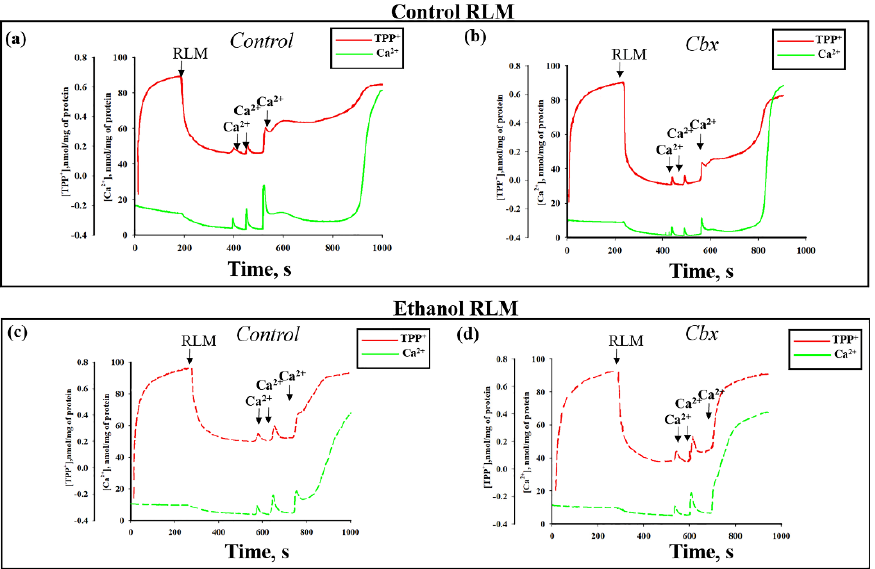
Figure 1. Effect of Carbenoxolone (Cbx) on the Ca 2+ transport (green lines) and membrane potential changes (red lines) in the Control ( a , b ) end Ethanol ( c , d ) RLM. The arrows indicate where CaCl 2 (50, 90 and 90 µM, respectively) was added to the mitochondrial suspension. RLM (1 mg/ml) were incubated in a standard medium, as described in Section 4.